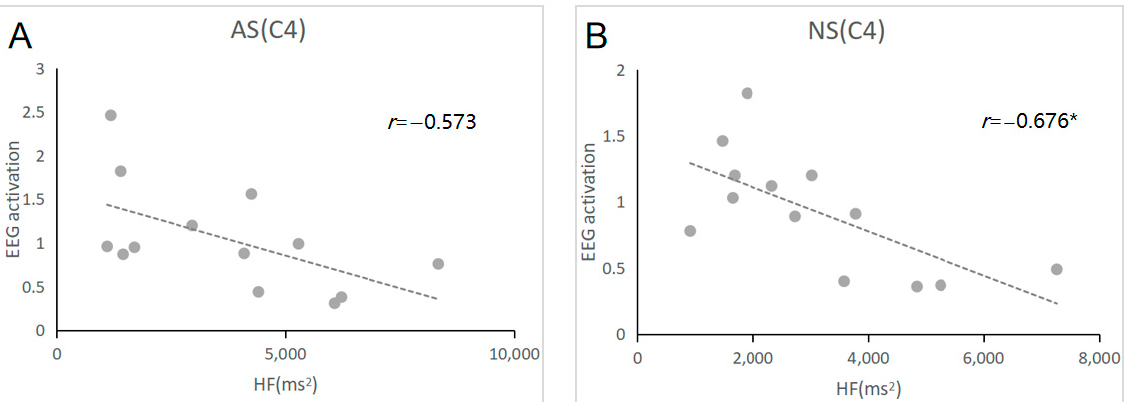
Figure 2. Association between HF and EEG activation during stage N2 at the C4 electrode. Note: Night 1 (shown in ( A )) and Night 2 (shown in ( B )). * p < 0.05.